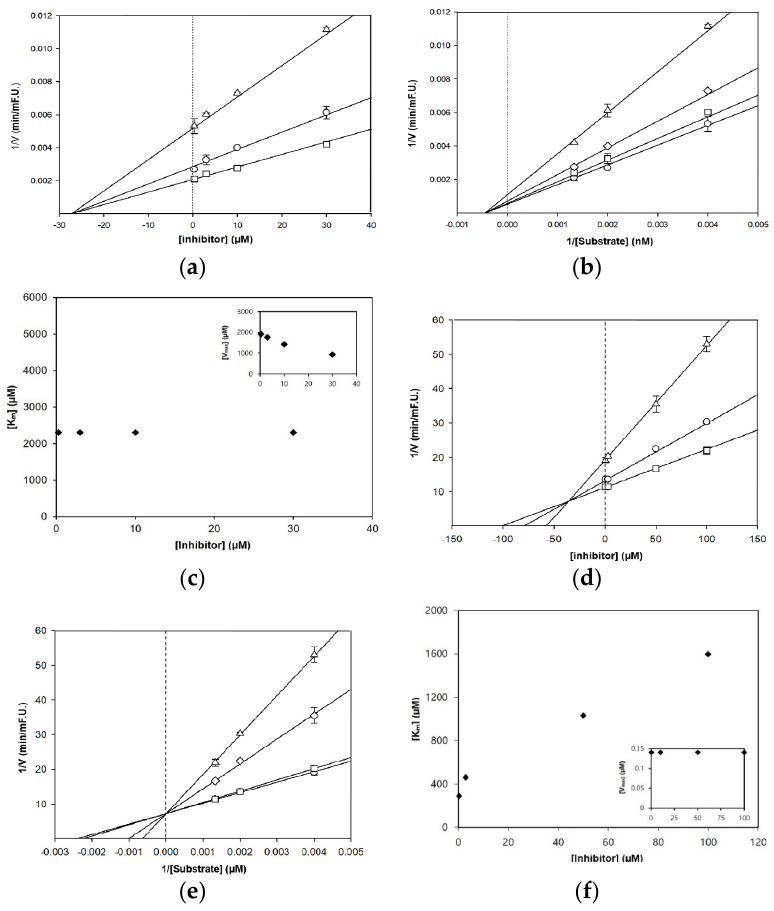
Figure 2. Dixon and Lineweaver–Burk plots for the inhibition of BACE1 ( a – c ) and AChE ( d – f ) by baicalein. Dixon plot of BACE1 inhibition by baicalein in the presence of different substrate concentrations: 250 nM ( ∆ ), 500 nM ( о ), and 750 nM ( □ ) ( a ). Dixon plot of AChE inhibition by baicalein in the presence of different substrate concentrations: 250 µM ( ∆ ), 500 µM ( о ), and 750 µM ( □ ) ( d ). Lineweaver–Burk plot was analyzed in the presence of different inhibitor concentrations: 0.3 µ M ( ), (cid:35) 3 µ M ( (cid:3) ), 10 µ M ( ♦ ), and 30 µ M ( ∆ ) ( b ); and 0.3 µ M ( ), 3 µ M ( (cid:3) ), 50 µ M ( ♦ ), and 100 µ M ( ∆ ) ( e ). Km (cid:35) values as a function of the concentrations of baicalein (Inset) Dependence of the values of Vmax on the concentration of baicalein ( c , f